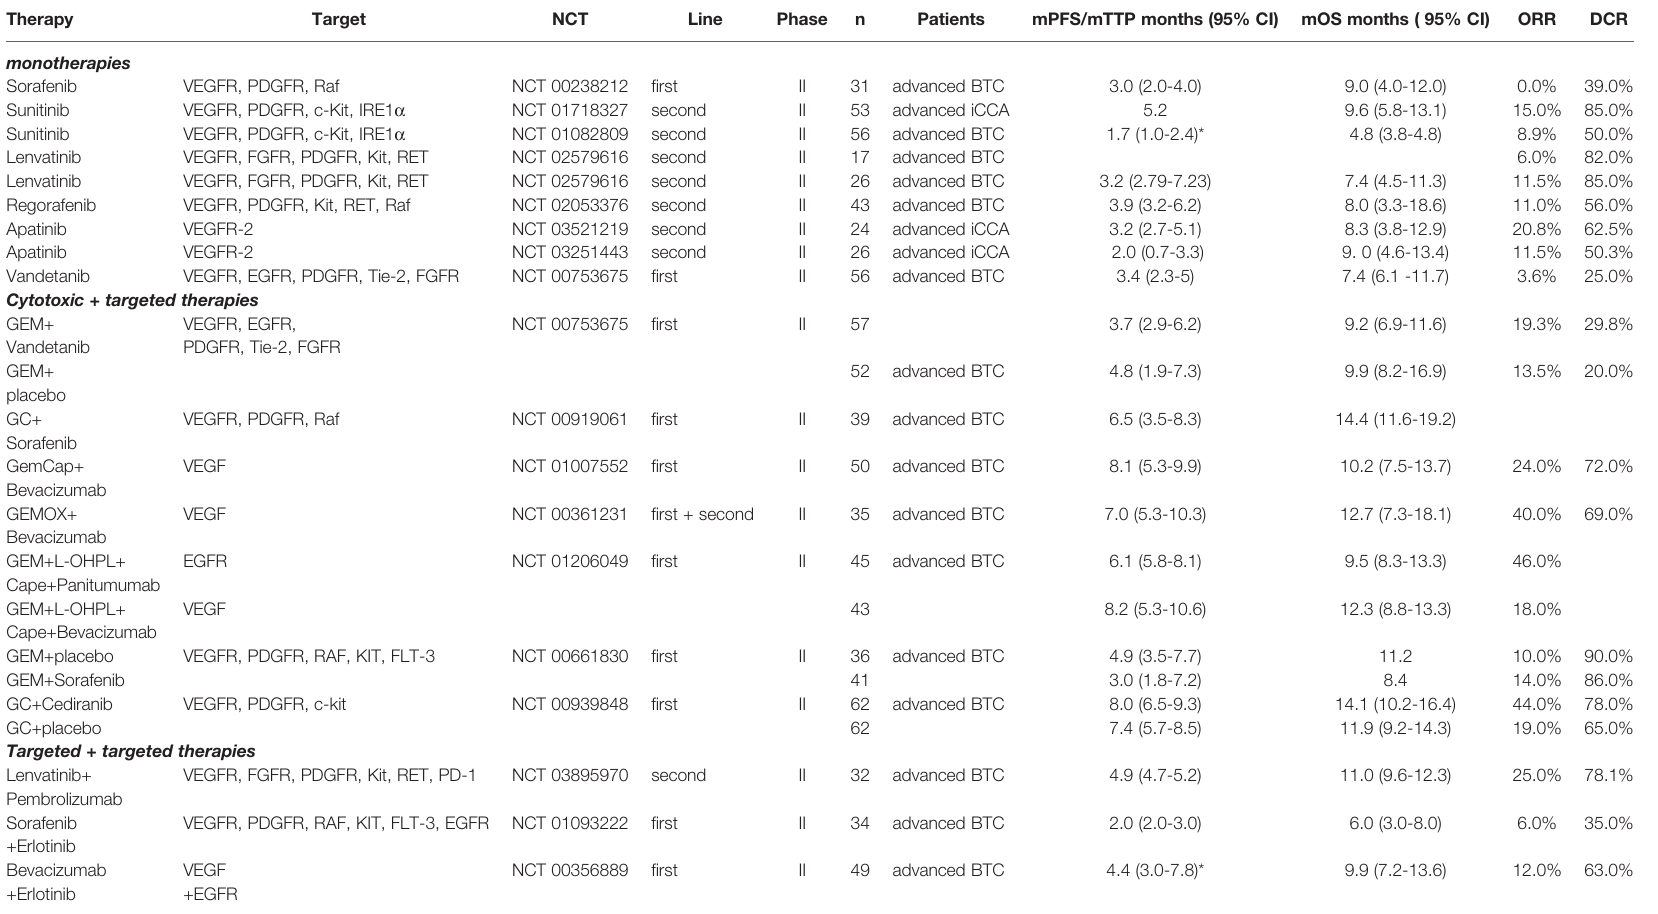
TABLE 1 | Anti-angiogenic drugs of BTCs in phase